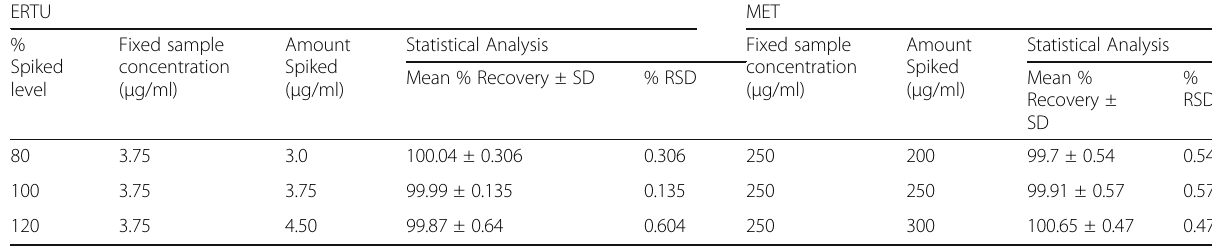
Table 3 Accuracy (% recovery) of ERTU and MET